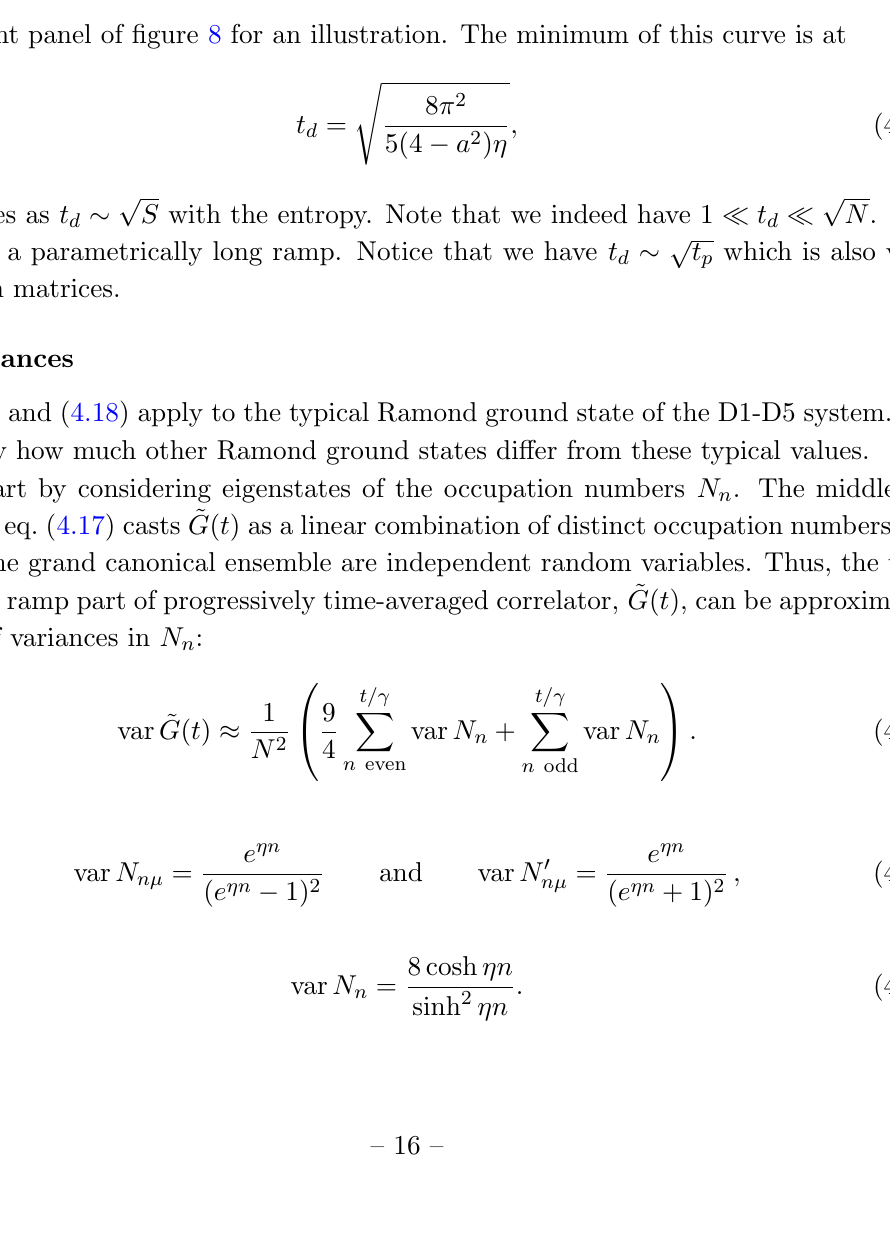
Figure 8 . Left: the black dots represent the progressive time-average of the regularized two point function (4.1), the blue line is the progressive time-average of the BTZ two point function (4.25), the yellow line is the ramp estimate (4.18), while the green line is the sum of the latter two, i.e. the function (4.26). Right: same as the left, with the addition of: purple line is the BTZ asymptote (4.27); the dark orange line is the curve (4.28). Both (cid:12)gures are for (cid:17) = 0 : 005 and use (cid:13) = 2, (cid:14) = 0 : 55 and a =